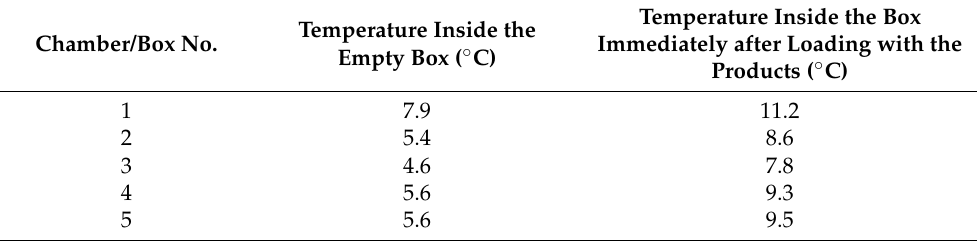
Table 2. Temperatures in individual cooling module boxes during product loading.